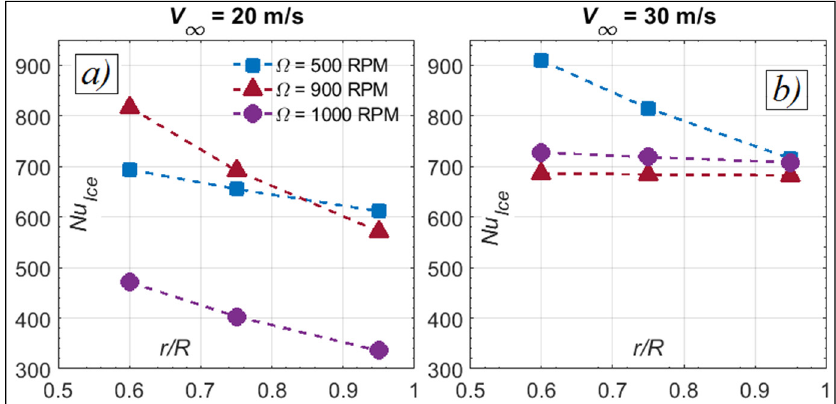
Figure 15. Variation in the Calculated Nu Ice with Respect to r/R for the De-Icing Tests with T ∝ ≈ 258.15 K and at ( a ) V ∝ = 20 m/s and ( b ) V ∝ = 30 m/s.